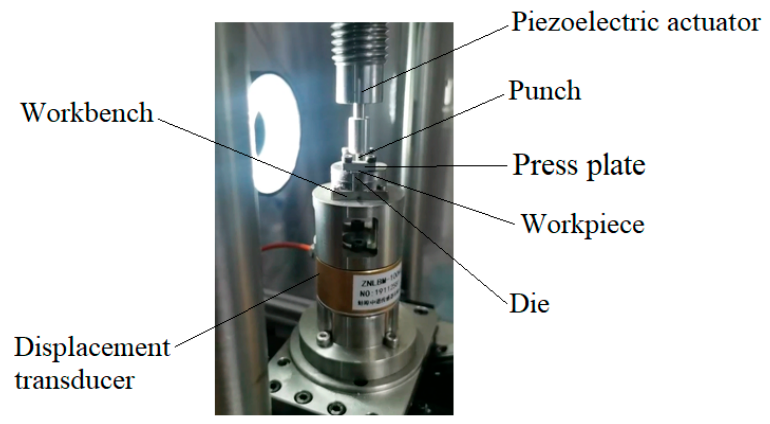
Figure 9. Stress effect of billet in different simulation steps.